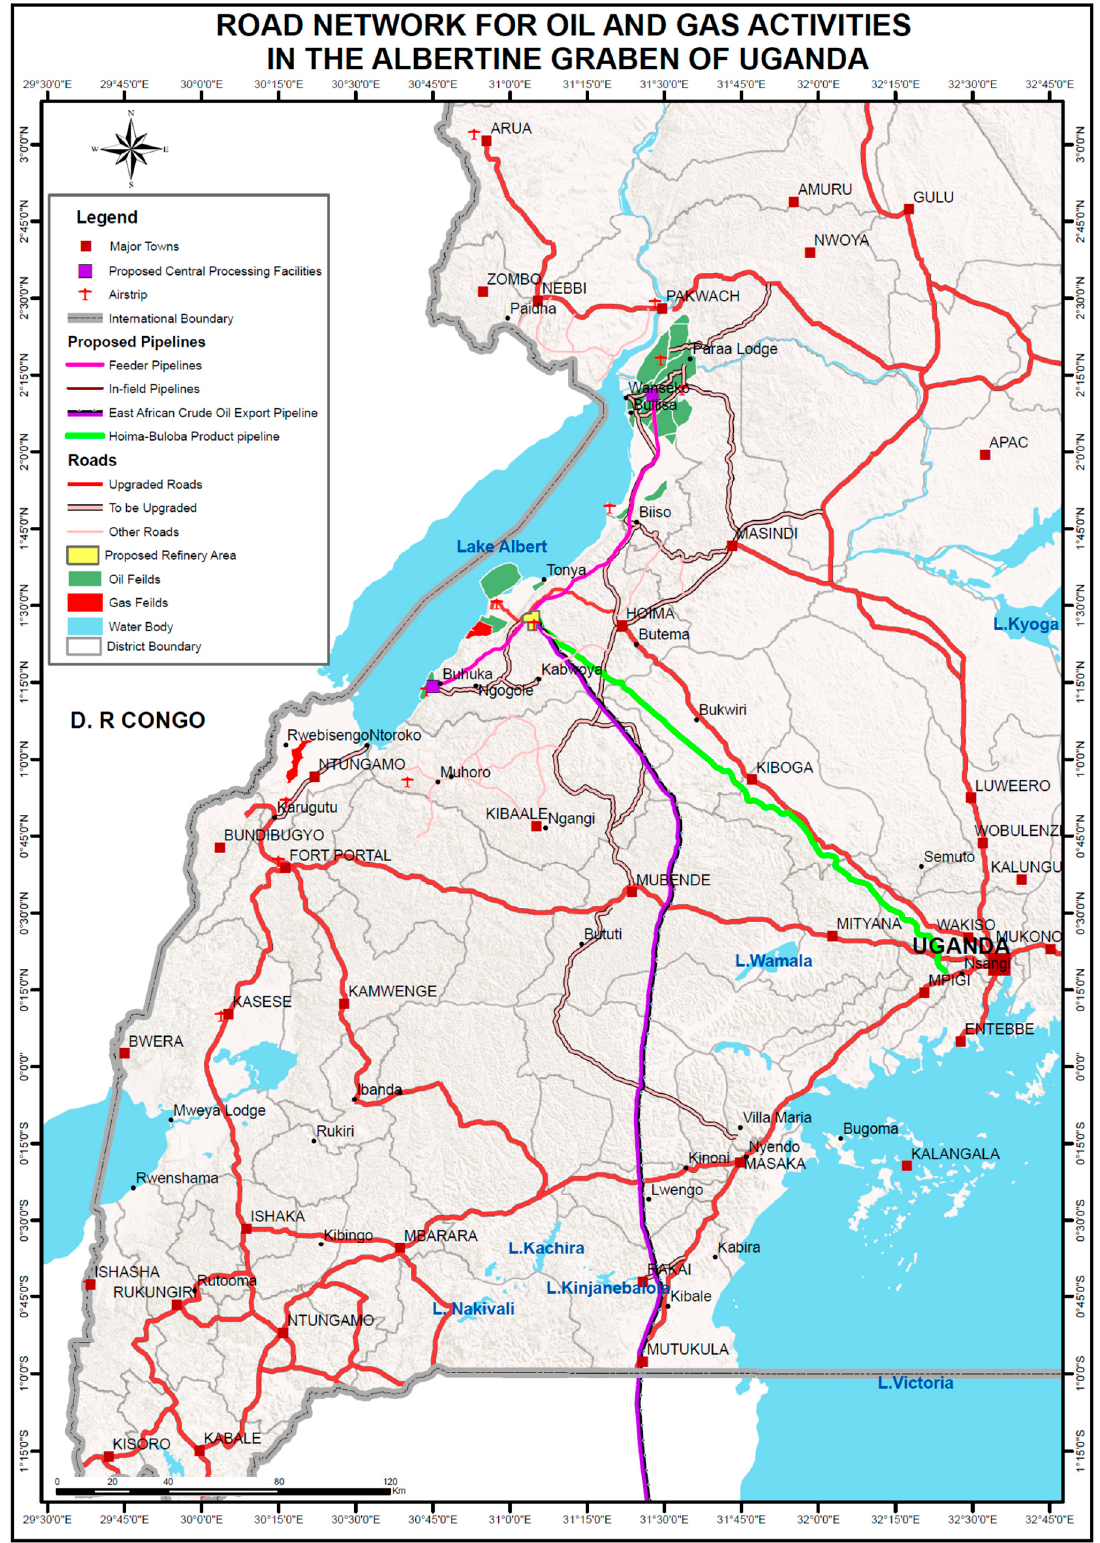
Figure 3. Map showing the position of the Hoima–Kampala Petroleum Products Pipeline. Source: Petroleum Authority of Uganda (2019) https://pau.go.ug/uploads/ROAD_NETWORK_AG.pdf.